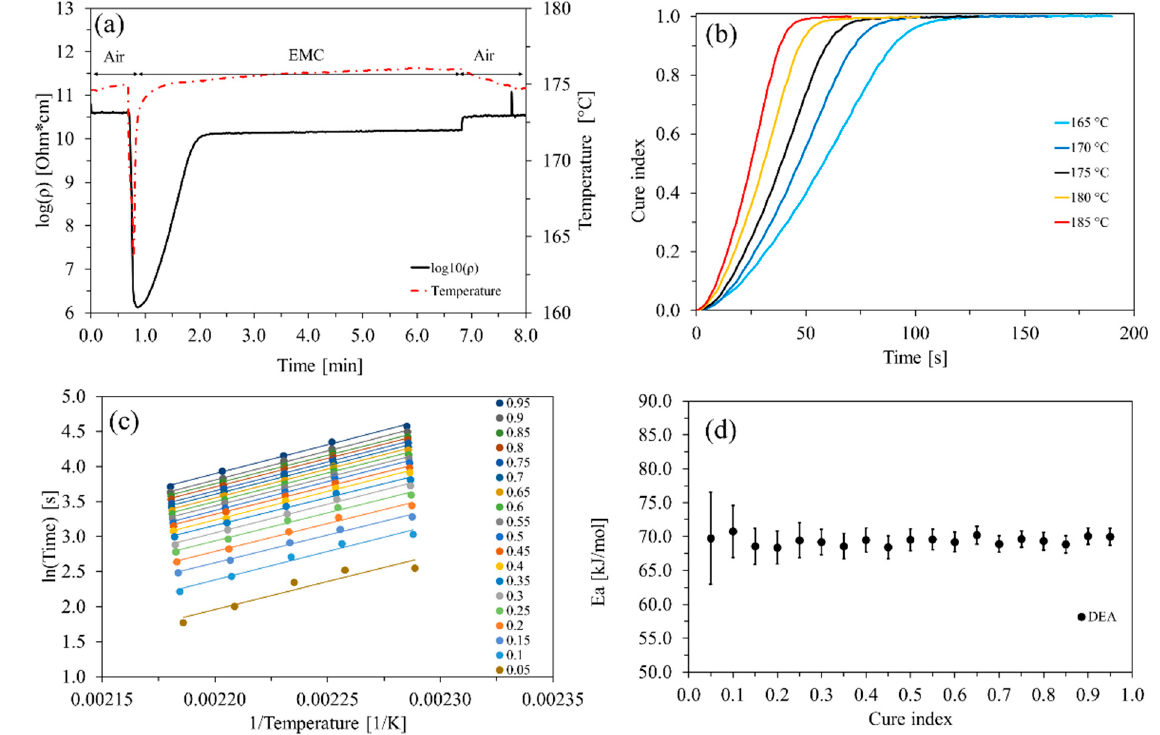
Figure 5. DEA evaluation: ( a ) ion viscosity and temperature plotted against time ( b ) Cure index at different isothermal temperatures plotted against time; ( c ) natural logarithm of time plotted against the reciprocal of the absolute temperature (integral isoconversional method) at specific cure indeces with the corresponding regression lines; ( d ) apparent activation energy E a plotted against the cure index with standard error.